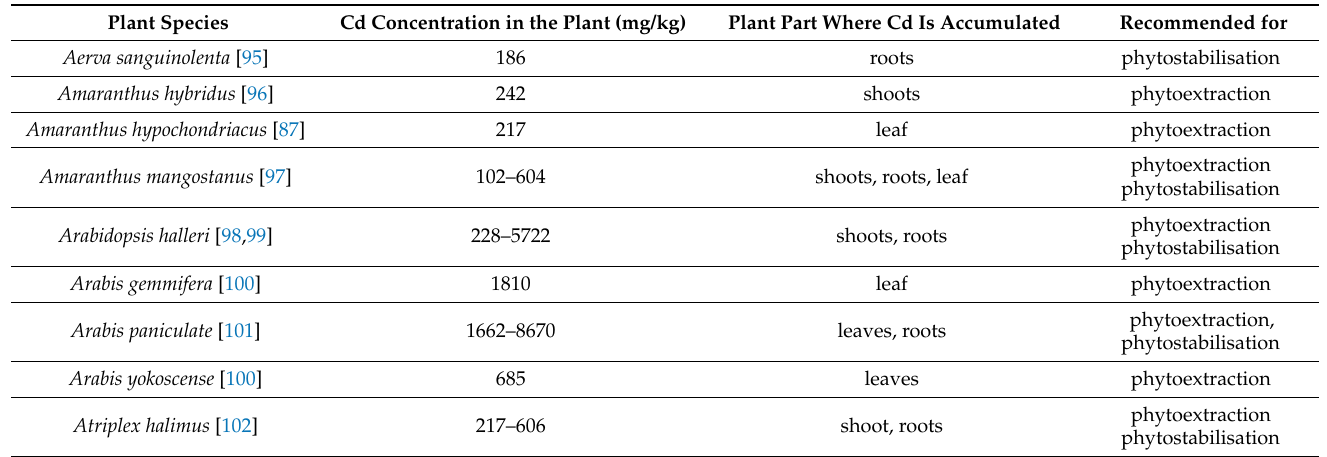
Table 1. The list of the plants which have shown potential for application in phytoremediation and their rate of cadmium accumulation (Table summarizes data for the past 5 years according to the data available on Web of Science